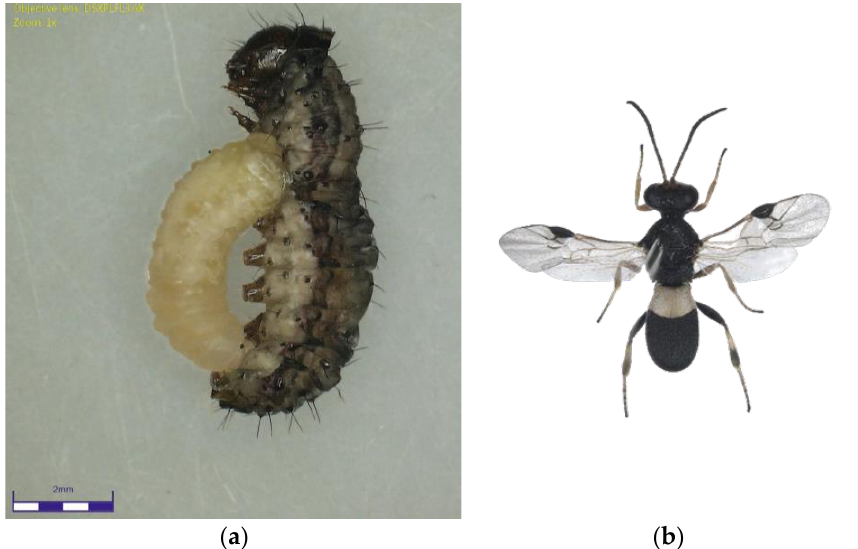
Figure 1. ( a ) Chelonus nr. blackburni larva emerging from the Fall Armyworm larvae; ( b ) Chelonus nr. blackburni adult.